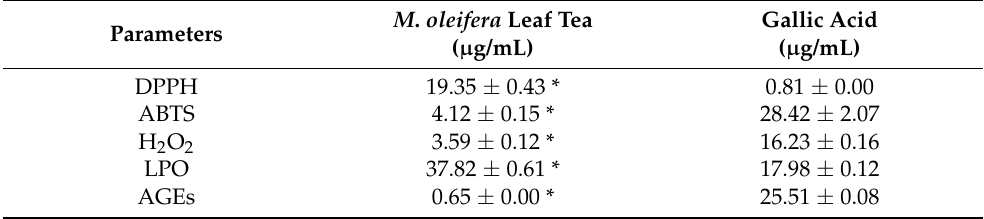
Table 1. The half-maximal inhibitory concentration (IC50) values of DPPH, ABTS, H 2 O 2 scavenging